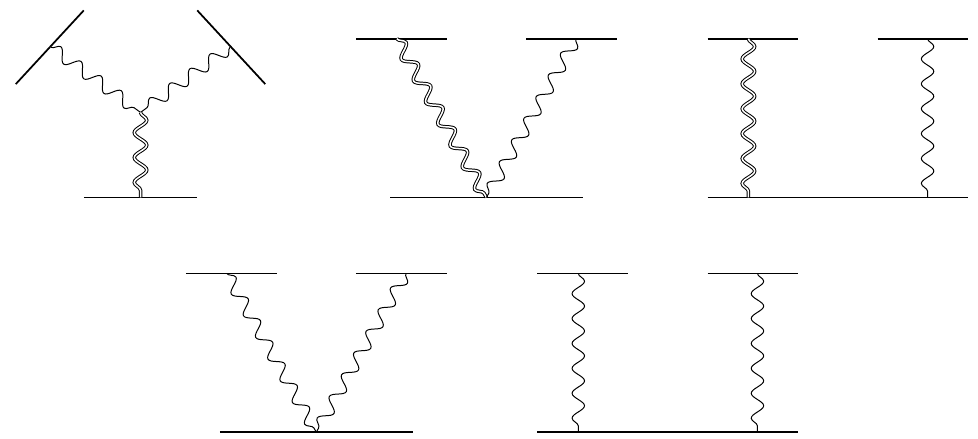
Figure 5 . Additional Feynman diagrams contributing to the 3-body scattering of charged massive scalars in Einstein-Maxwell at O (cid:0) G 2 (cid:1) . Single wavy lines correspond to photons, and double wavy lines to